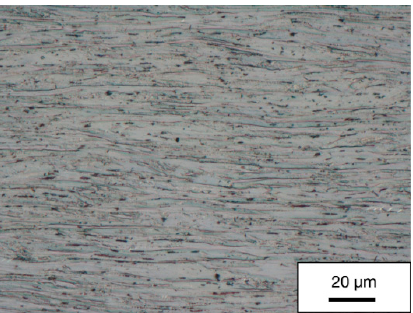
Figure 8. Micrograph of rotary-swaged material in the longitudinal direction after a 90% reduction of cross-sectional area.